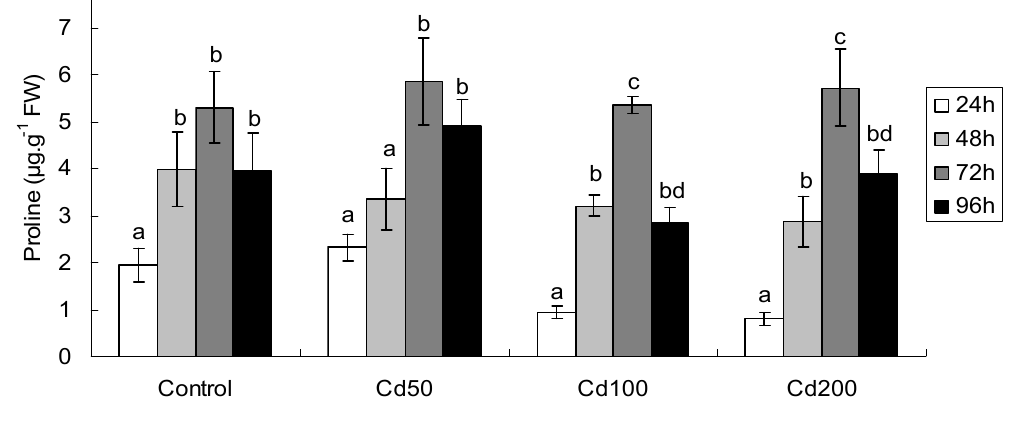
Figure 4. Proline concentration germinating soybean seeds after different periods of exposure. All values are mean ±SD (n = 4). Values followed by lower case letters are significant at p <